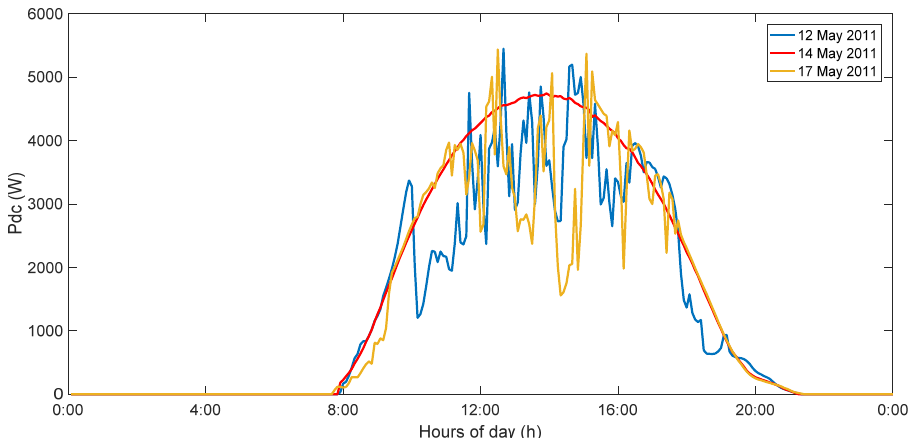
Figure 19. Daily profiles of the dc power generated by the PV panels during 12, 14 and 17 May 2011.